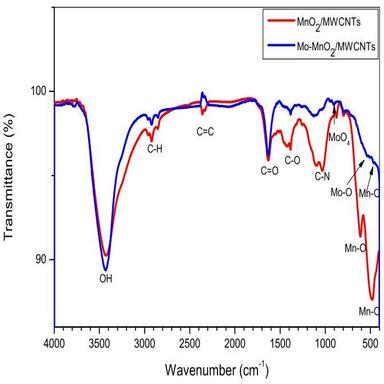
FTIR spectra of mesoporous (MnO2/MWCNT) and mesoporous (Mo–MnO2/MWCNT).